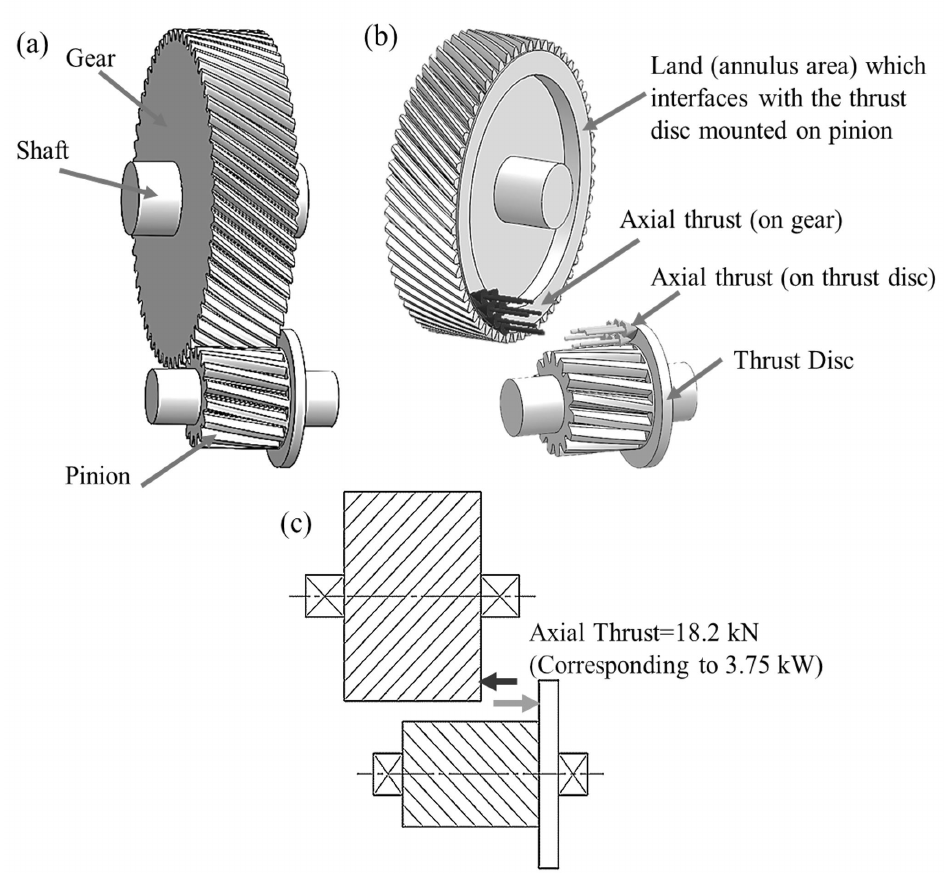
Figure 4. ( a ) CAD model of meshed pinion and gear; ( b ) schematic demonstration of axial thrust acting at the interface of gear and thrust disc; ( c ) magnitude of axial thrust acting at 3.75